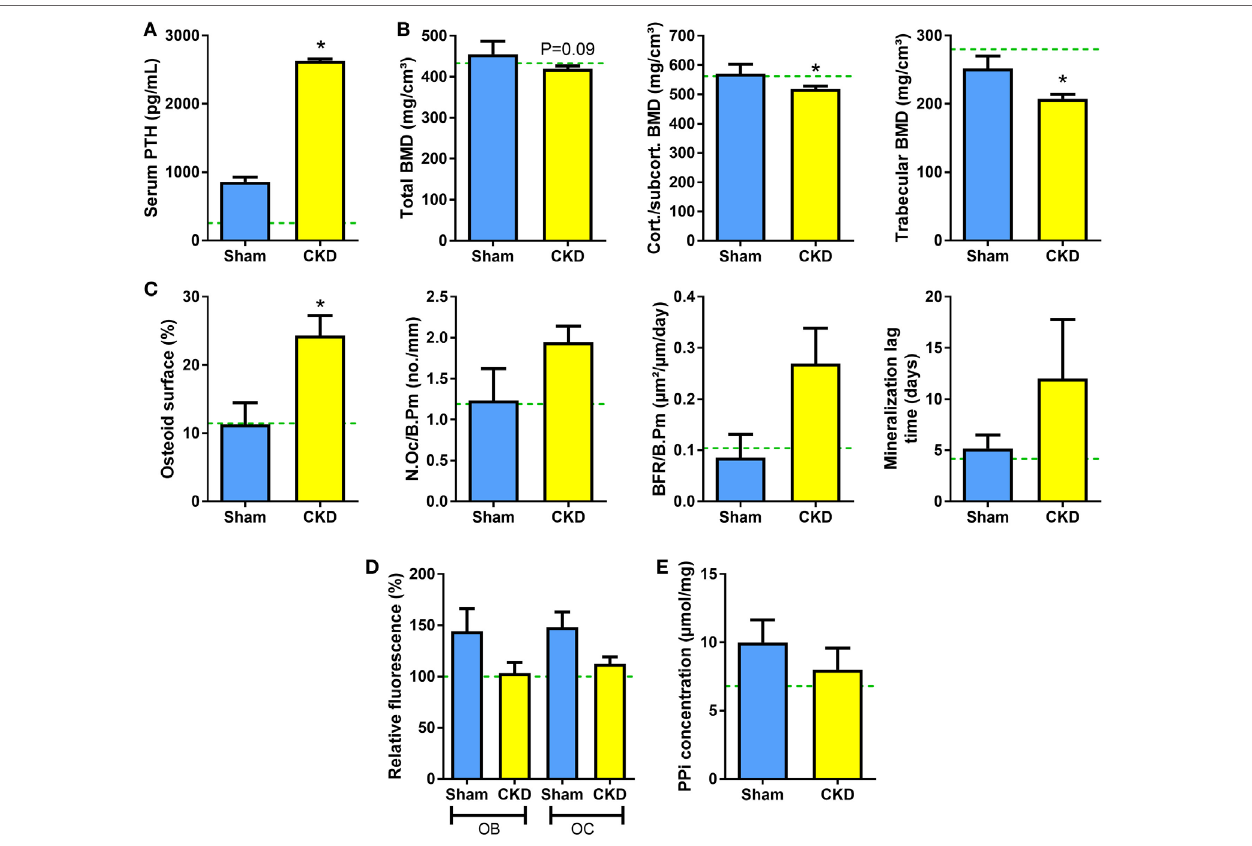
FigUre 5 | 5/6-Nx induces bone loss in Fgf23 /VDR compound mutant mice, but does not alter tissue nonspecific alkaline phosphatase (TNAP) activity or pyrophosphate concentration in bone. (a) Serum parathyroid hormone (PTH) ( n = 13 each), (B) total, cortical/subcortical, and trabecular bone mineral density (BMD) of the L2 lumbar vertebra [4 Sham, 17 chronic kidney disease (CKD)], (c) osteoid surface (4 Sham, 14 CKD), number of osteoclasts (4 Sham, 14 CKD), bone formation rate (3 Sham, 10 CKD), and mineralization lag time (3 Sham, 10 CKD) in proximal tibial cancellous bone, (D) histochemical TNAP staining of undecalcified sections of proximal tibiae and quantification of relative fluorescence in osteoblasts (OB) and osteocytes (OC) ( n = 3–5 each), and (e) pyrophosphate (PPi) concentration in extracts of femurs ( n = 4–6 each) from 5-month-old male Sham and CKD Fgf23 /VDR compound mutant mice on rescue diet, 8 weeks postsurgery. Data are mean ± SEM. Green dotted lines represent mean values found in wild-type (WT) Sham mice. The data in (D) were normalized to the WT Sham group. In (a–c) , * denotes P < 0.05 vs. Sham by t -test or Mann–Whitney U -test, as